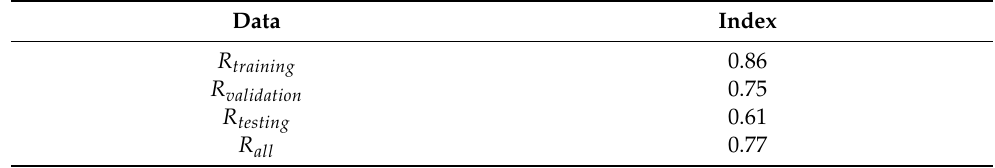
Table 7. Regression indexes for the neural network during training, validation, and testing.